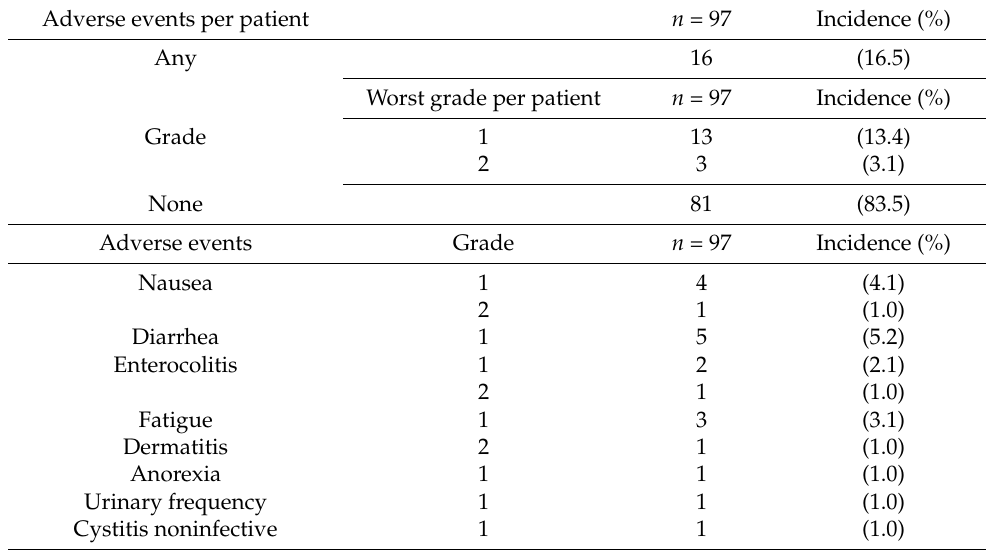
Table 2. Adverse events before